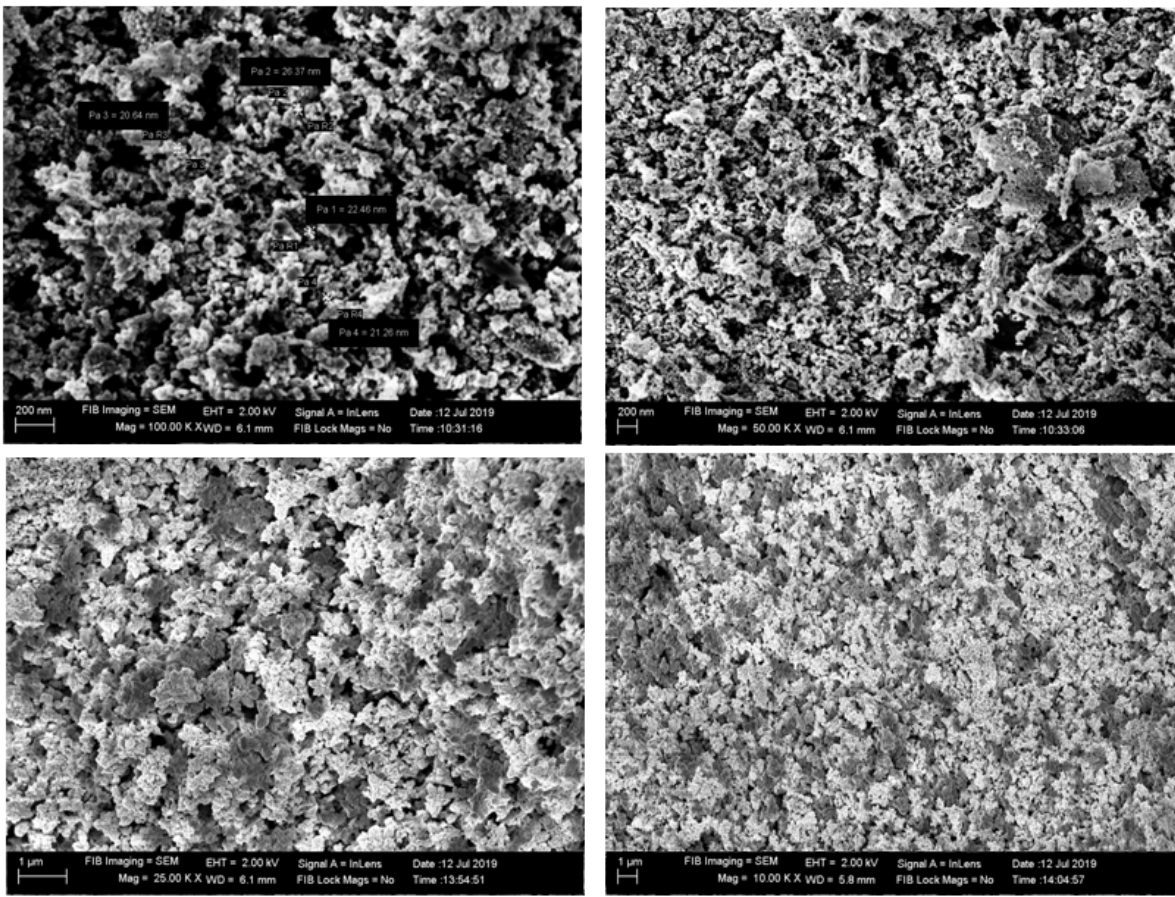
Figure 11: SEM micrographs of ZnO NPs synthesized at pH